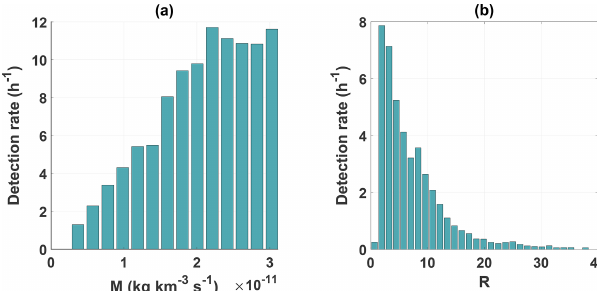
Figure 3. Number of observed steepened waves per hour as a func- tion of mass loading (a) and the normalized cometocentric dis- tance R (b)